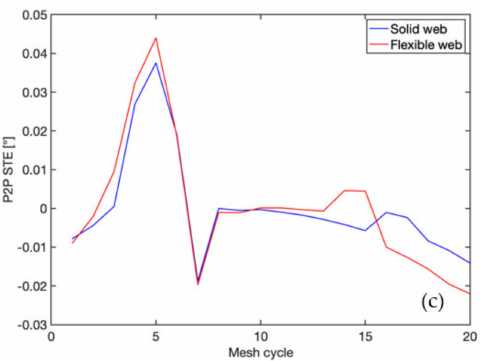
Figure 6. STE evaluation for the solid web ( a ), flexible web ( b ) and the comparison of the peak-to-peak STE between the two solutions ( c ).